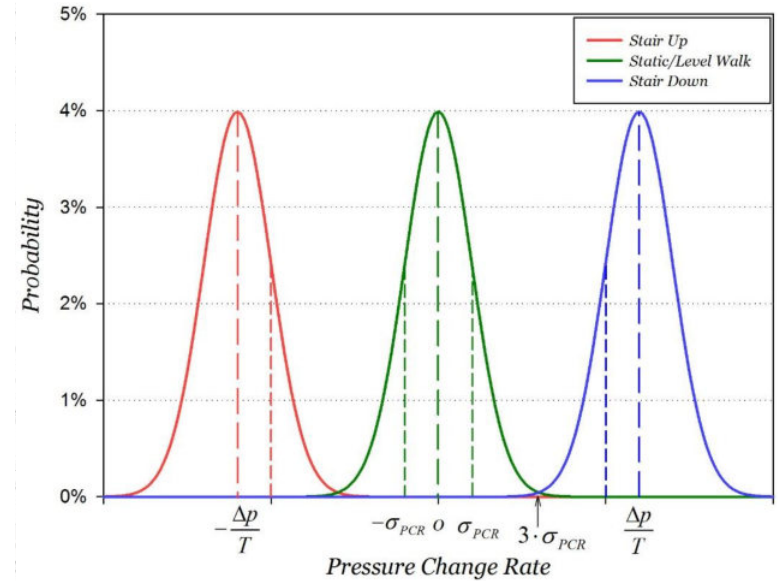
Figure 2. Distinguish H-motions and V-motions using